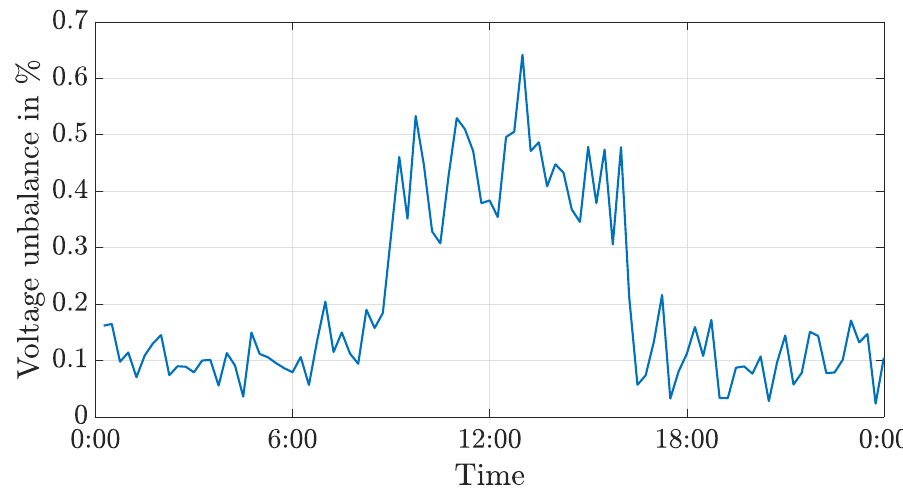
Figure 9. Voltage unbalance at the end of the feeder.